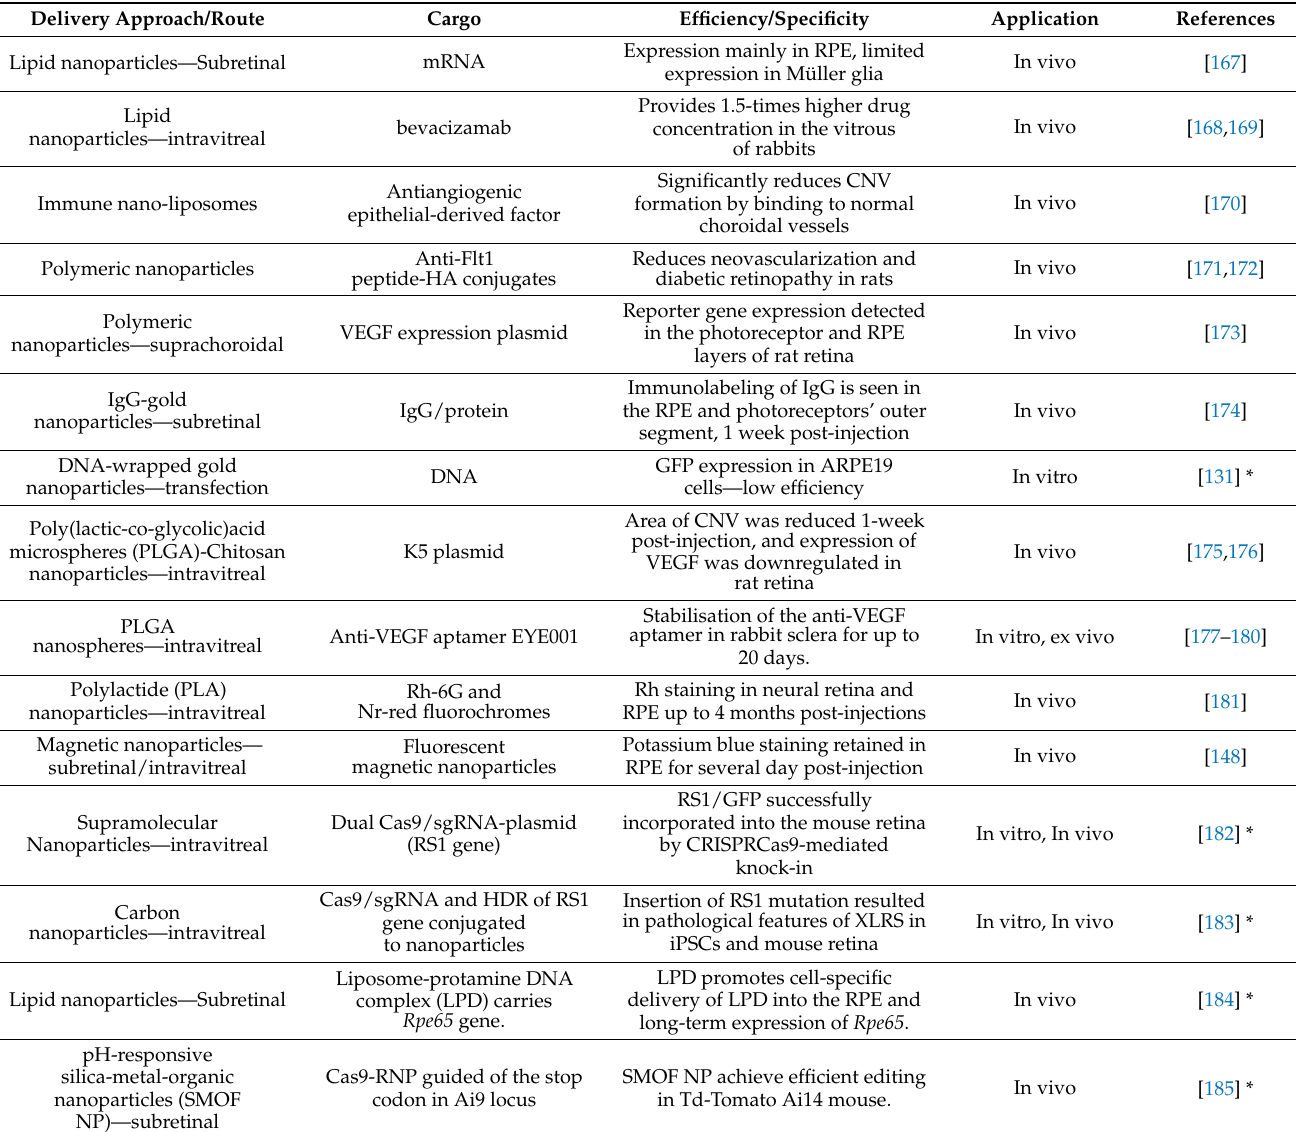
Table 1. Selected examples of nanoparticle cargo delivery in the retina. (* refers to the use of